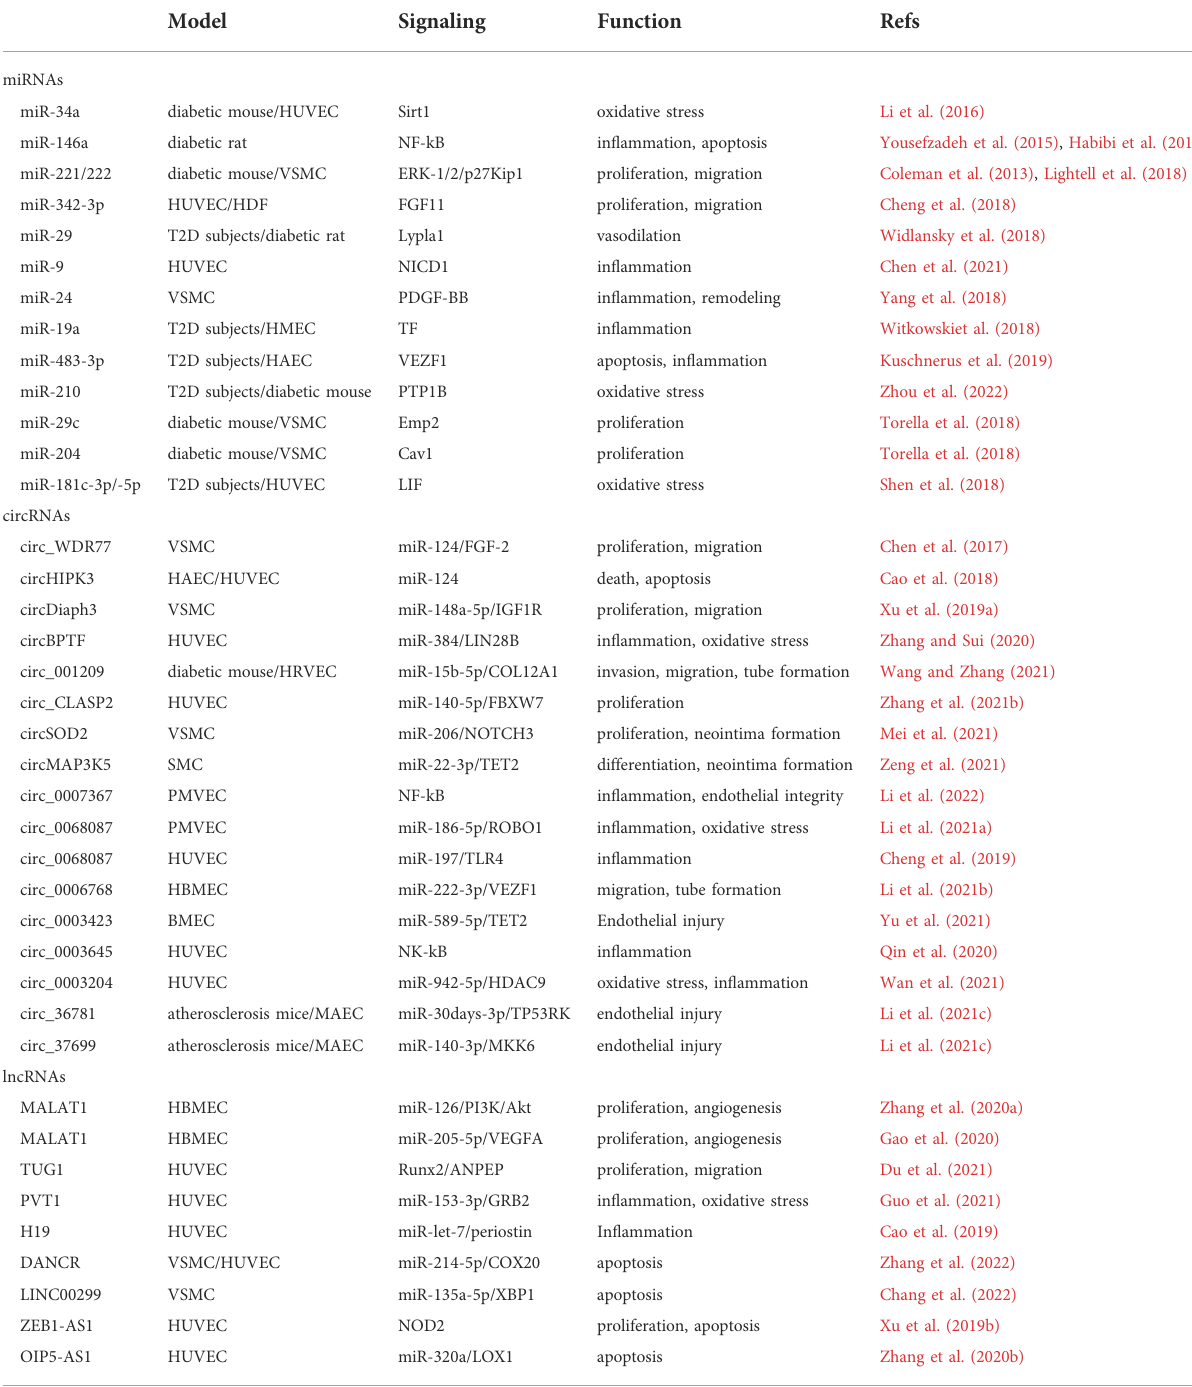
TABLE 1 ncRNAs associated with vascular dysfunction in diabetic patients and